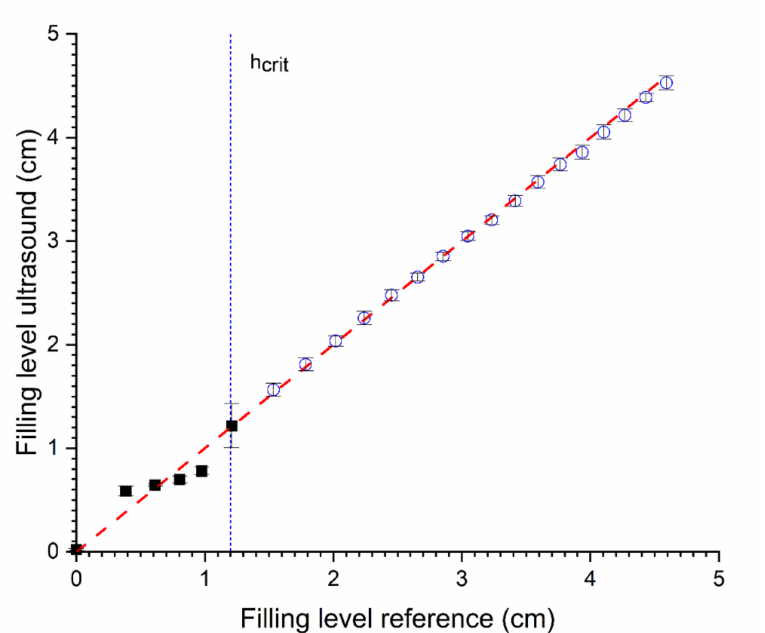
Figure 8. Relationship between the predicted level by combined prediction of filling level with SAW (0–1.2 cm) and pulse-echo prediction (>1.2 cm) and reference (volumetric determination). R 2 = 0.99 and RMSE = 0.07 (N =